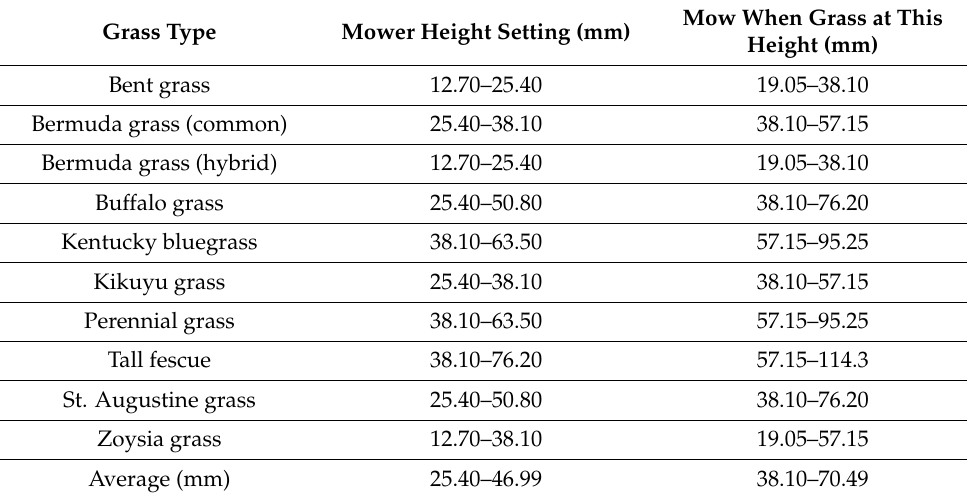
Table 26. Proper mowing height for different types of grasses